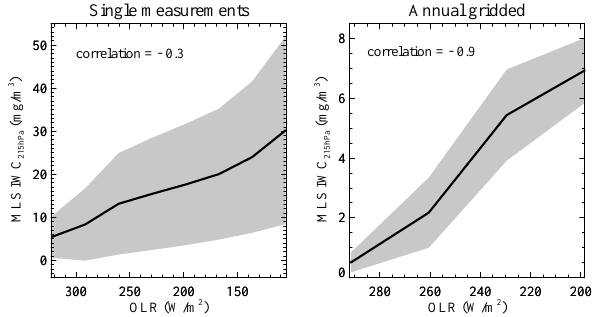
Fig. 1. Left column: The black curve is the MLS measured IWC at 215hPa binned as a function of collocated GEOS-5 OLR. All single MLS IWC measurements between August 2004 and July 2008 in the tropical region (30 ◦ S–30 ◦ N) are used. The GEOS-5 data are sampled onto the MLS footprints. The standard deviations of the data are indicated by the gray shaded area. Right column: Same as left column except for gridded (8 ◦ longitude by 4 ◦ degree latitude) data averaged for the 4